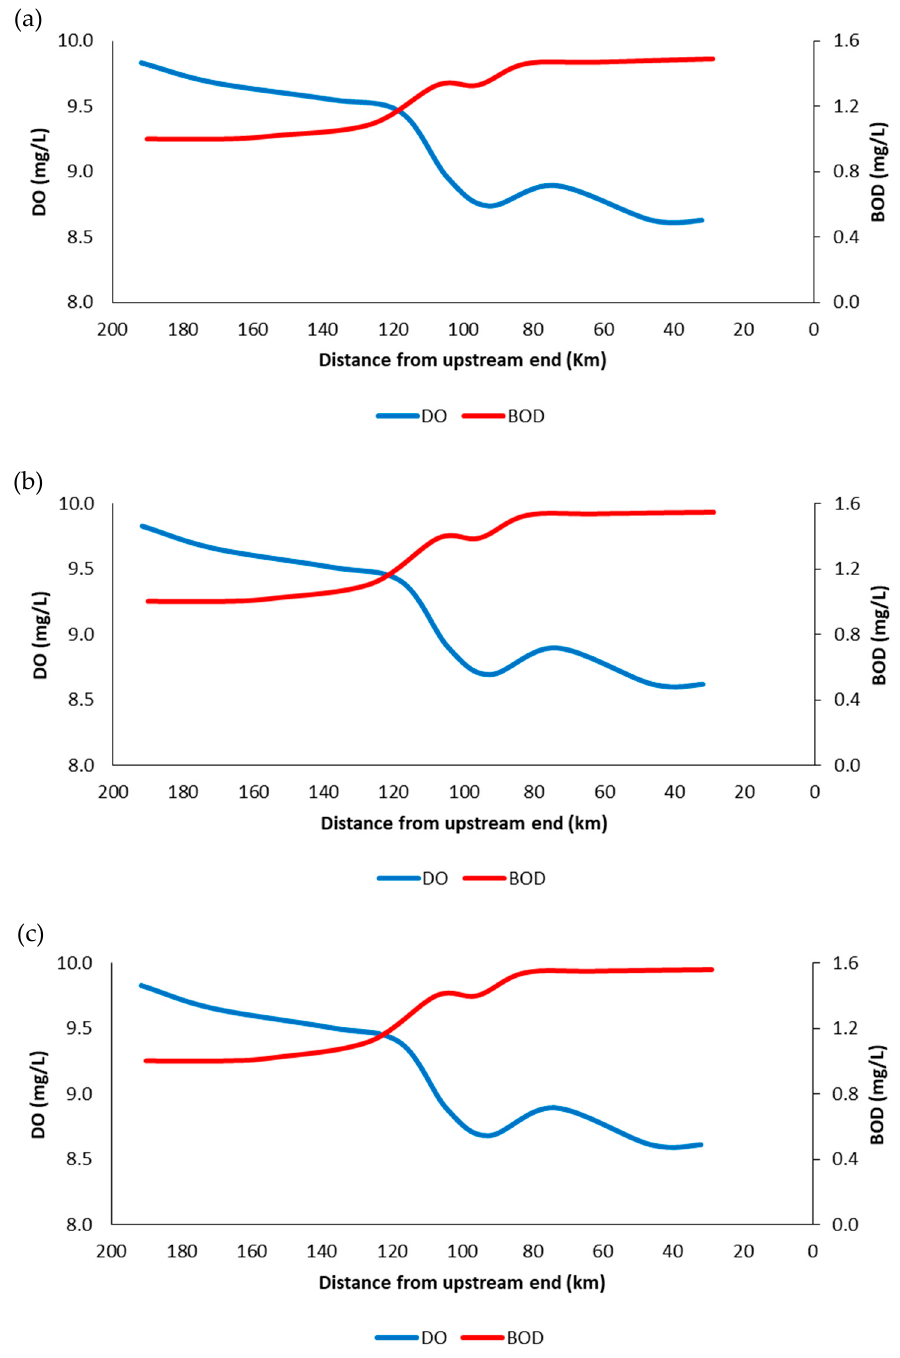
Figure 4. Modeling of DO v/s BOD 5 concentrations for ( a ) 5-year return period; ( b ) 50-year return period, ( c ) 100-year return